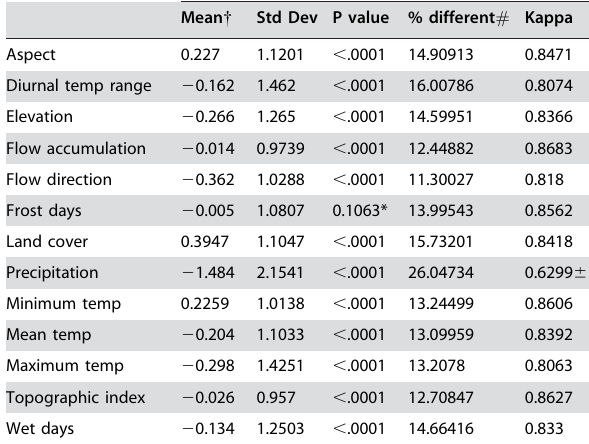
Map layer excluded Difference from all-layers map